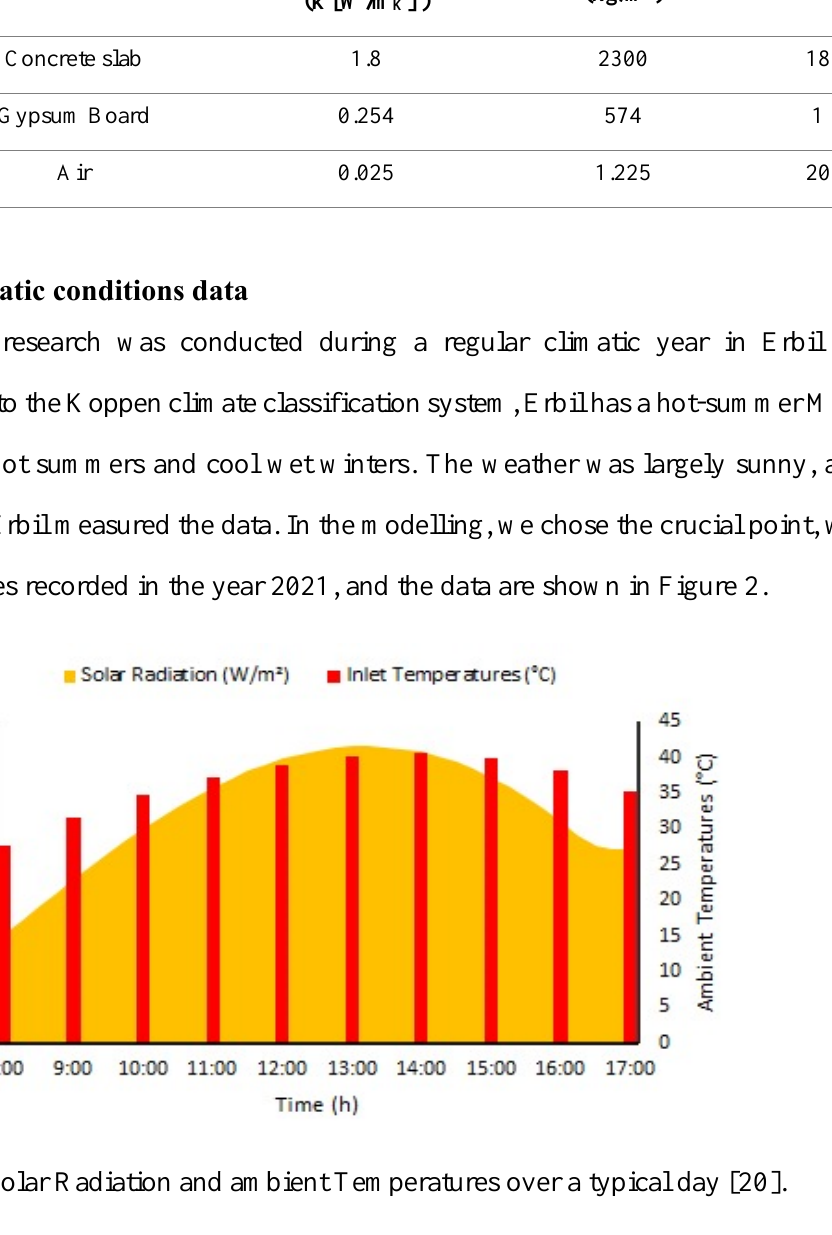
Table 1. The properties of the material Thermal conductivity Density No Material Thickness(cm) Emissivity (kg/m 3 ) (k [W/m K ] ) Concrete slab 1.8 2300 0.85 Gypsum Board 0.254